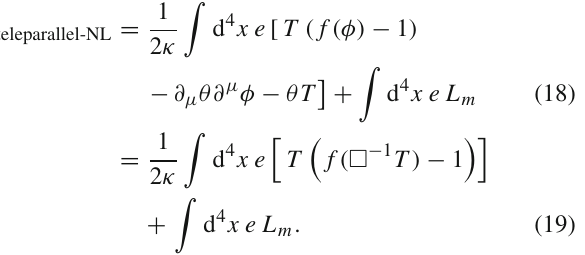
Fig. 1 The diagram shows how to recover the different theories of gravity starting from the scalar-field representation of the general the- ory. Note that φ = (cid:2) − 1 T and ϕ = (cid:2) − 1 B so that − φ + ϕ = (cid:2) − 1 R .